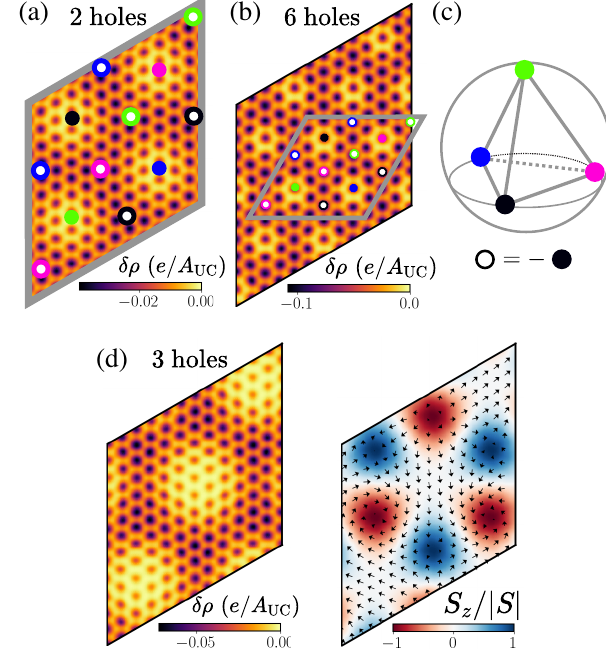
FIG. 11. Spin skyrmions about QAH (spinful ν ¼ þ 3 ). FIG. 12. Spin skyrmion crystallization about QAH (spinful ν ¼ þ 3 ). (a),(b) Charge density when adding two and six holes, (a) Charge density of a single hole about the ν ¼ þ 3 QAH state. (b) Topological density ρ computed from the spatial spin respectively. Gray parallelogram indicates the supercell. (c) In the top configuration of (a). (c) Energy of single-electron and hole double-tetarton lattices of (a),(b), the spins at particular positions − E skyrmions Δ E ¼ E 1 e (anti) align along the corners of a tetrahedron in spin space. 1 e ð h Þ (relative to a particlelike ð h Þ skyr (d) Charge and z component of local spin orientation when electron or hole excitation) as a function of system size L . adding three holes, leading to a meron lattice. System size is (d) Local spin orientation S ð r Þ = j S ð r Þj corresponding to the 12 × 12 with the graphene scheme. skyrmion in (a). The spins are rotated so that the state has a net polarization along z . System size is 16 × 16 with the graphene starting insulator is easy axis in valley space. The low- energy charged topological excitations are then expected to be spin skyrmions [36,37,51] in the partially filled Chern sector without any texturing in the fully filled Chern sector.